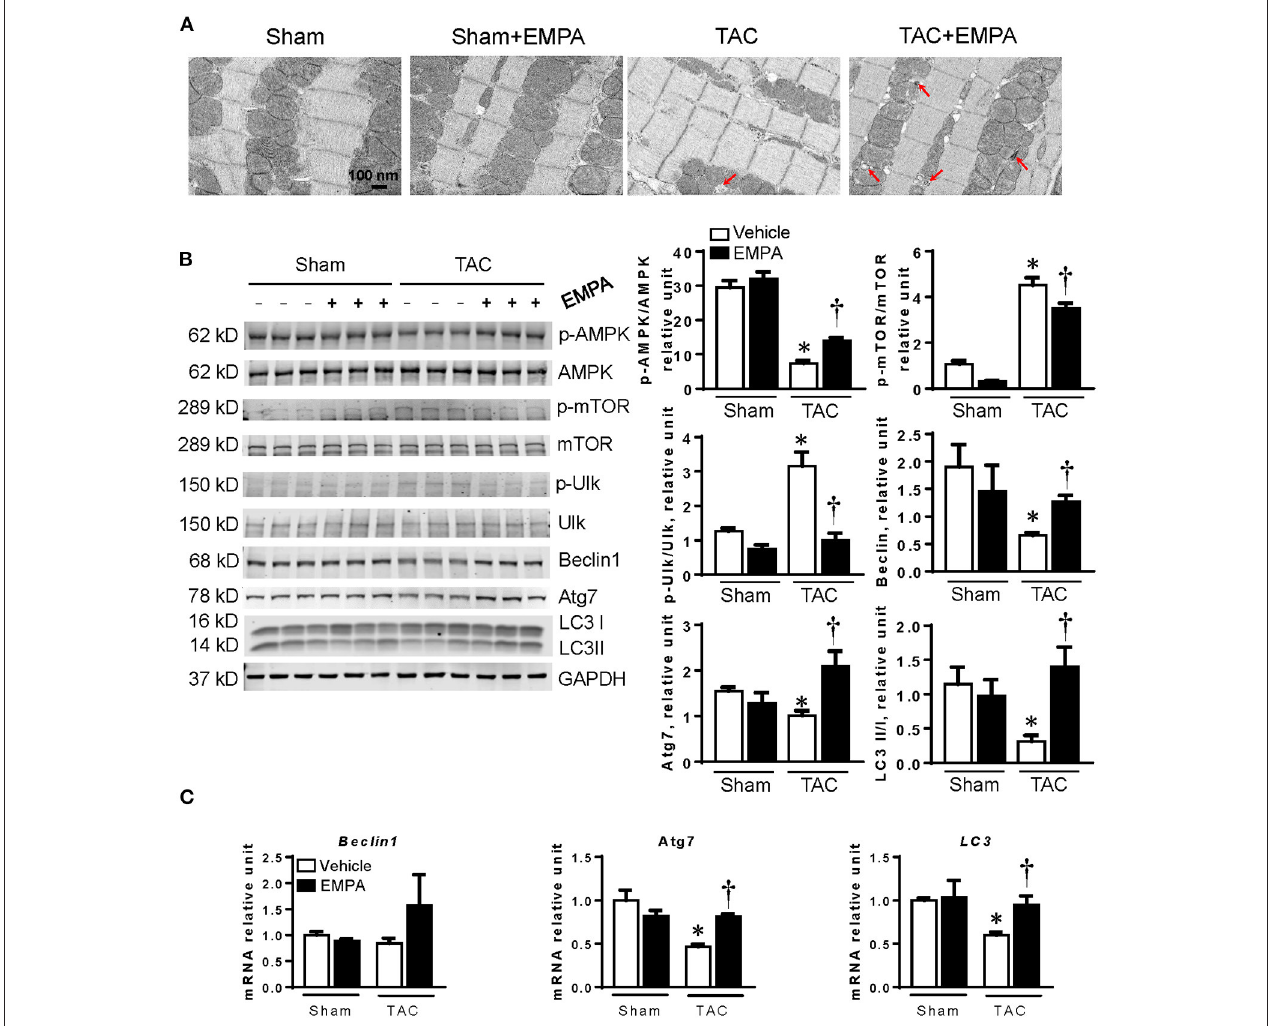
FIGURE 5 | EMPA treatment enhanced autophagy in failing hearts. (A) Transmission electron microscopy (TEM) showed autophagosomes in the hearts. Red arrows point to autophagosomes. (B) EMPA activated autophagy pathway by inhibiting mTOR pathway. (C) RT-PCR results showed that the mRNA expression of Beclin1, Atg7 and LC3 were increased by EMPA treatment after TAC. Results are expressed as mean ± SEM, n = 5–7, * p < 0.05 vs. corresponding sham group, † p < 0.05 vs. corresponding TAC vehicle group. One-way ANOVA and Tukey post hoc test. EMPA, empagliflozin; SEM, standard error of the mean; TAC, transverse aortic constriction; AMPK, AMP-activated protein kinase; mTOR, mammalian target of rapamycin; Ulk, Unc-51 like autophagy activating kinase; Atg7, autophagy related 7; LC3, light chain 3; GAPDH, glyceraldehyde 3-phosphate